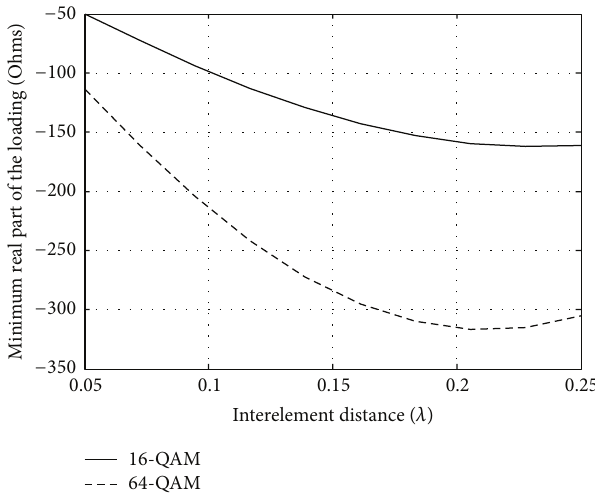
Figure 4: Minimum negative resistance value according to theory simulation.